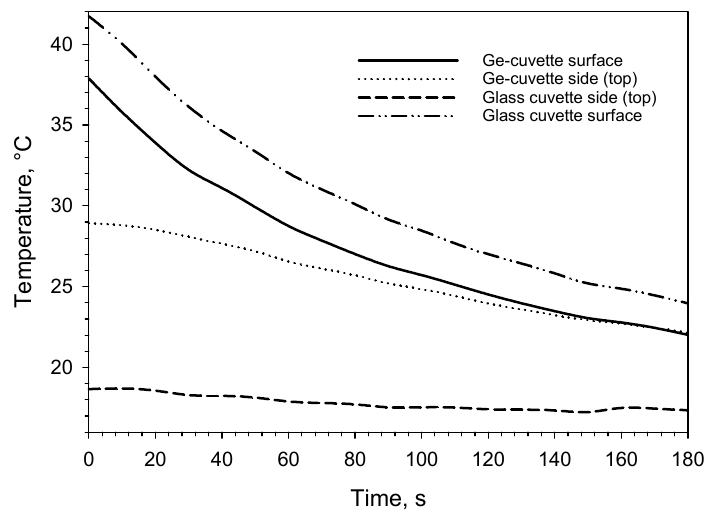
Figure 3. Time profiles of average temperature from ten IR pixels at the surface and ten IR pixels at the side (top) of the two cuvettes as shown in Figure 1a employing measurement areas as shown in Figure 4b. The olive oil is clearly warmer at the surface at the beginning of the experiment. After 120 s, the difference is only 0.5 °C between the surface and topside (about 2 mm down in the liquid) through the Ge ‐ window but for the glass window, the difference is still >12 °C between the surface and topside.